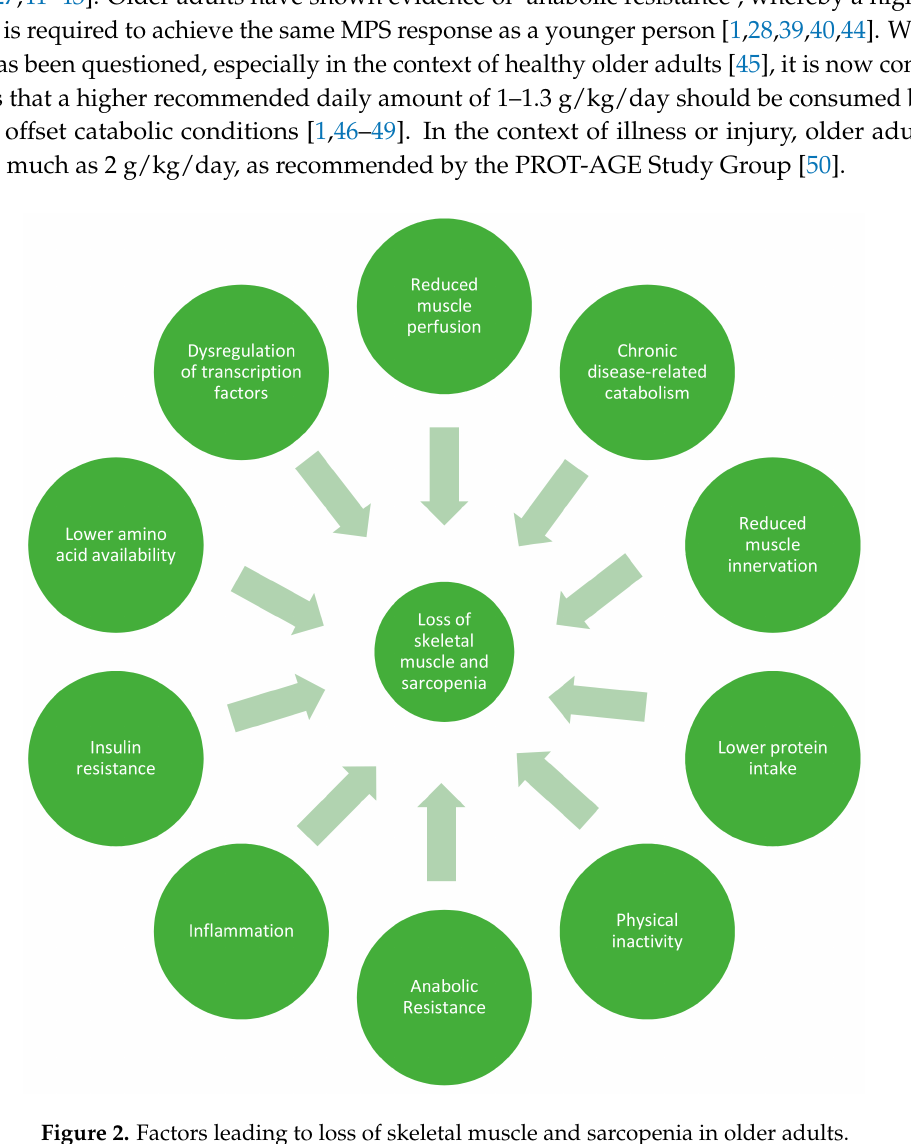
Figure 2. Factors leading to loss of skeletal muscle and sarcopenia in older